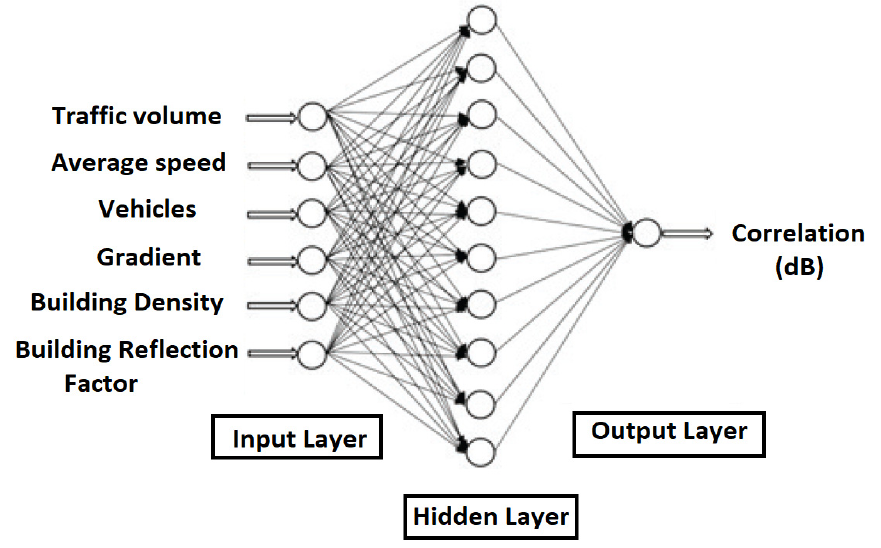
Figure 20. The proposed MFFC architecture for traffic noise analysis.